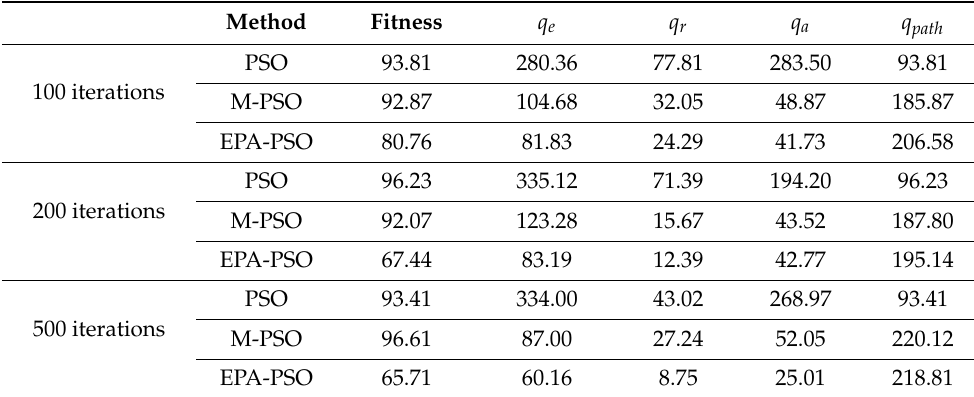
Table 3. The numerical analysis of cost function.